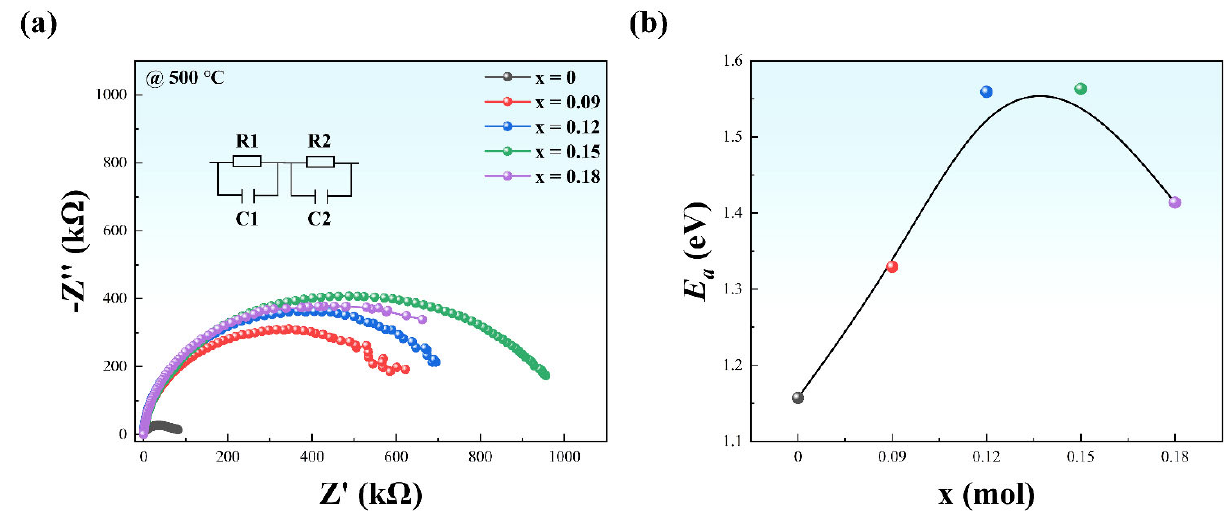
Figure 6. ( a ) The Nyquist plots (Z” vs. Z’) measured at 100~2 MHz and 500 °C for NBT ‐ SBT ‐ xBMZ ceramics (x = 0, 0.09, 0.12, 0.15, 0.18); ( b ) the E a as a function of x. Beyond that, the AGS also makes a critical impact on the DBS and is inversely propor- Table 2. Fitted values of equivalent circuit model for Nyquist plots. tional to the DBS according to Equation (7)